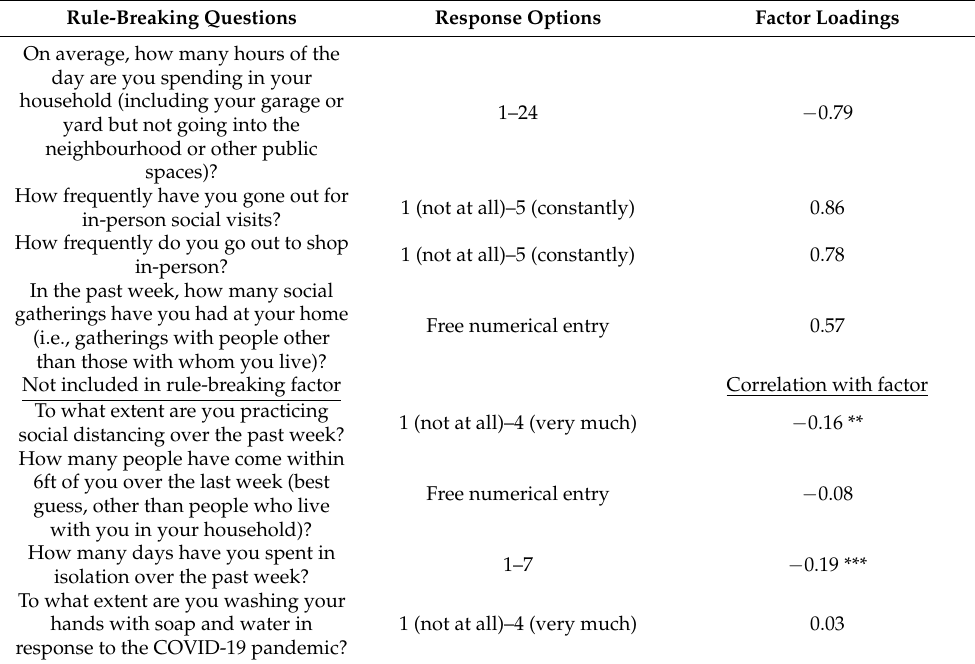
Table 2. Rule-breaking questions and accompanying factor loadings.